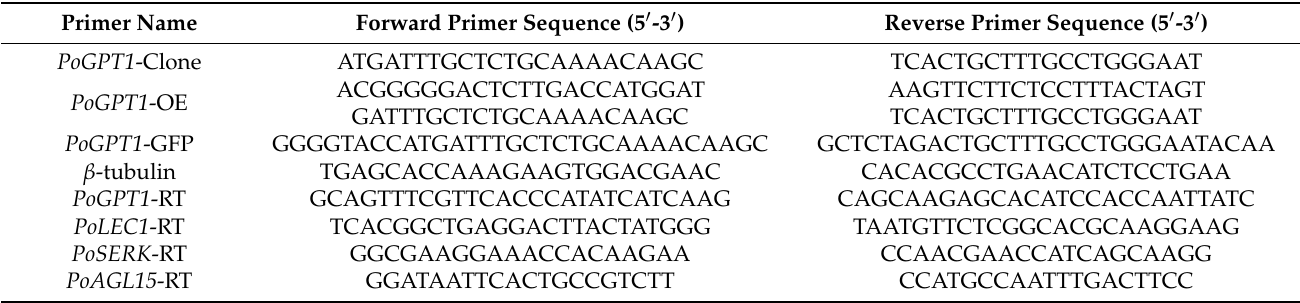
Table 1. Summary of primers used in the